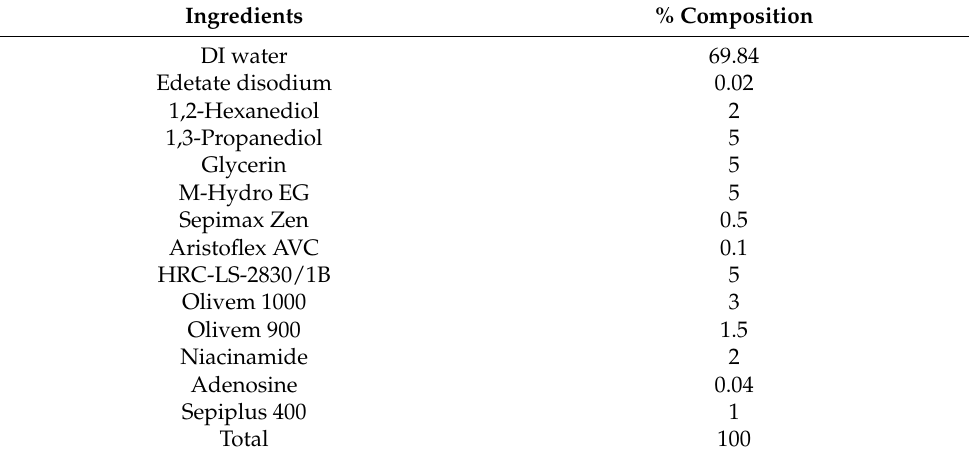
Table 4. Composition of component B in the elastic artificial skin.